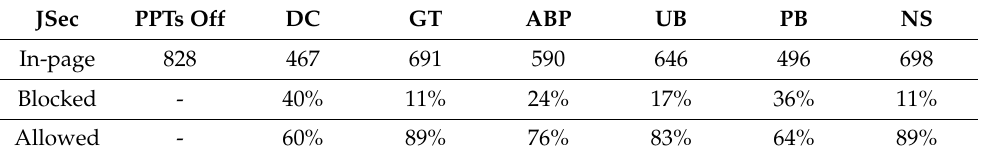
Figure 4. The total number of JavaScript programs extracted from the 50 domains. Table 3. The percentage of all allowed and blocked in-page JavaScript programs.